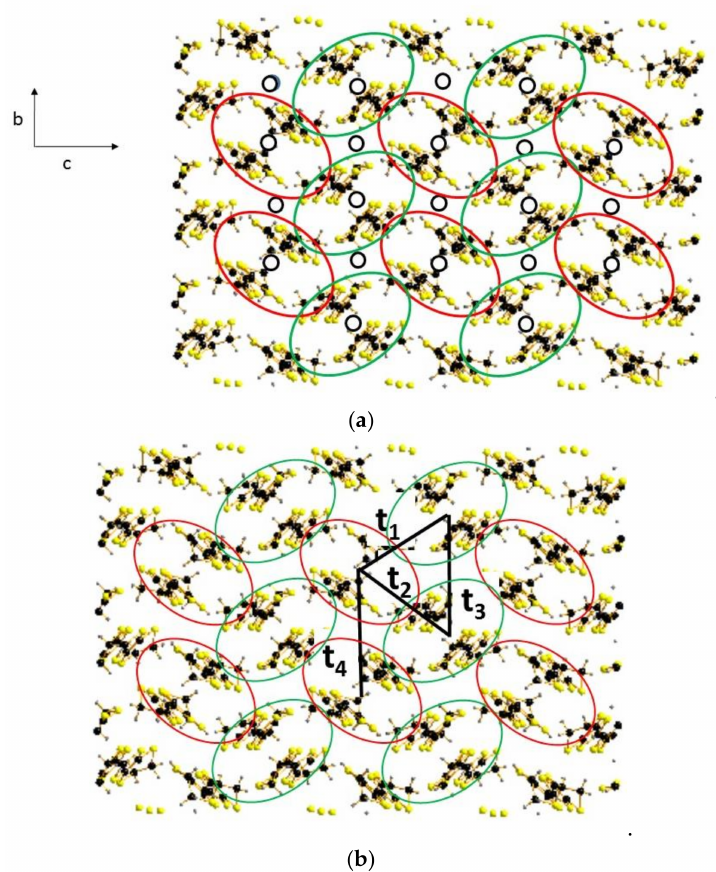
Figure 5. (Color online). ( a ) Molecular stack in the ( b , c ) plane showing the two types of dimers (red and green ellipses). The inversion centers remaining in the P1 space group are indicated by black empty circles; ( b ) The same molecular stack with the four different transfer integrals (t i with i = 1 to 4) between dimers represented by black